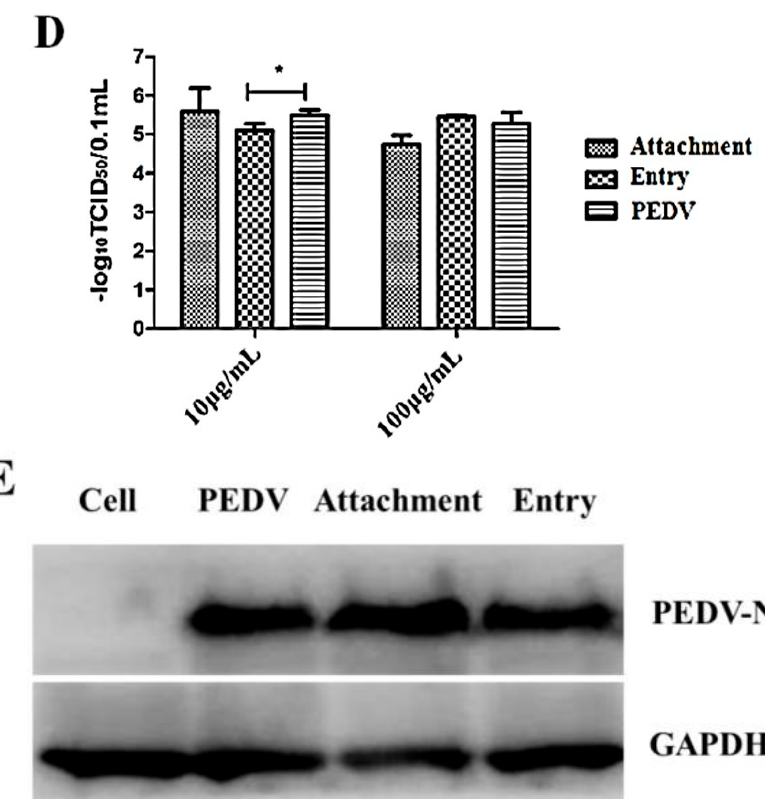
Figure 7. Caerin1.1 inactivates virus particles through direct interaction with porcine epidemic diarrhea virus (PEDV) particles. ( A ) Transmission electron microscopic images of Caerin1.1-treated viruses. (a) PEDV incubated with Caerin1.1 (10 μ g/mL) for 1 h at 37 °C. (b) PEDV control. In the images, the arrows indicate the complete (b) or destructed PEDV particles (a). Scale bars: 100 nm; ( B ) Tissue Culture Infectious Dose 50 (TCID 50 ) of Vero cells infected with PEDV under different concentration treatments of Caerin1.1. Pre-: Caerin1.1 was added 1 h before virus attachment. Co-: Caerin1.1 was incubated with PEDV for 1 h and the incubation compound was added to Vero cells. Post-: Caerin1.1 were added to Vero cells 1 h after virus entry process. PEDV without Caerin1.1 treatment acts as the control group; ( C ) Western blot analysis of the expression level of PEDV-N protein in different treatments of Caerin1.1 as shown in Figure 7B. GAPDH (glyceraldehyde-3-phosphate dehydrogenase) was used as a loading control; ( D ) TCID 50 showed that Caerin1.1 had no obvious inhibitory effects during the attachment and entry process. Caerin1.1 was added at PEDV attachment and entry periods, then the titers of PEDV were detected; ( E ) Western blot analysis of the expression level of PEDV-N protein when Caerin1.1 was added in different ways as shown in Figure 7D. GAPDH was used as a loading control.